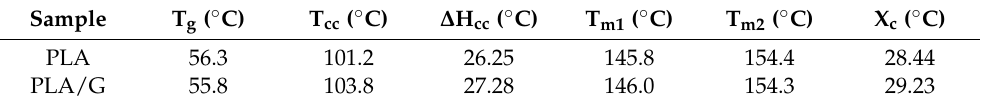
Table 4. DSC data obtained from the second heating scan for pure PLA and its composite with 1 wt.% graphene [72]. (Adapted with permission from ref. [72]. Copyright 2013 ACS